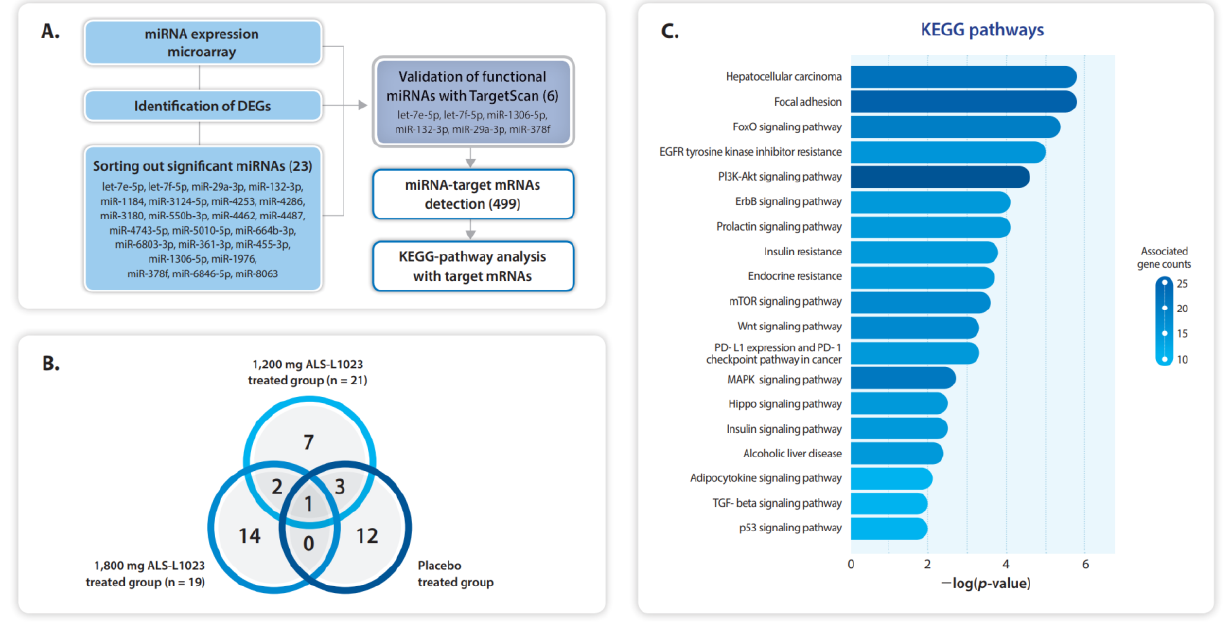
Figure 4. Putative miRNAs and target transcripts. ( A ) The schematic flow to select the putative miR- NAs and their target transcripts. The numbers in parenthesis are significant miRNAs (23), putative miRNAs (6), and putative targets (499). ( B ) Venn diagrams showing the number of significant miR- NAs from each administration group. ( C ) KEGG pathways of the putative targets.